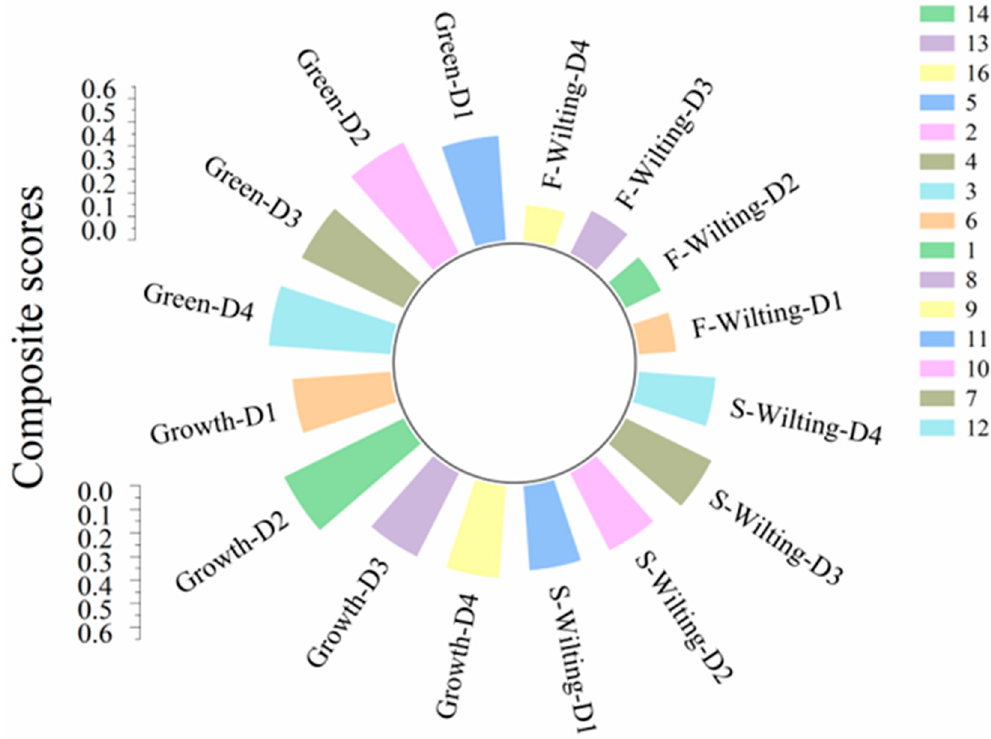
Figure 5. The TOPSIS result.